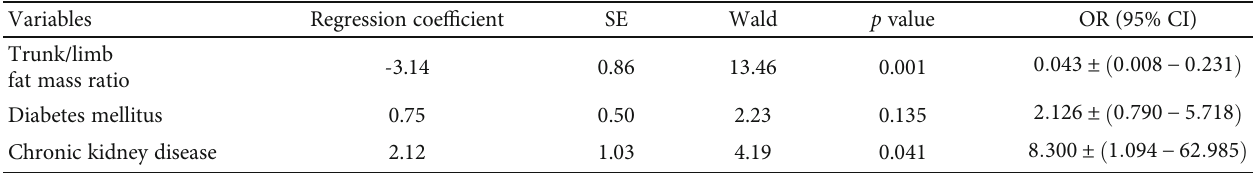
Table 2: Factors in fl uencing muscle mass